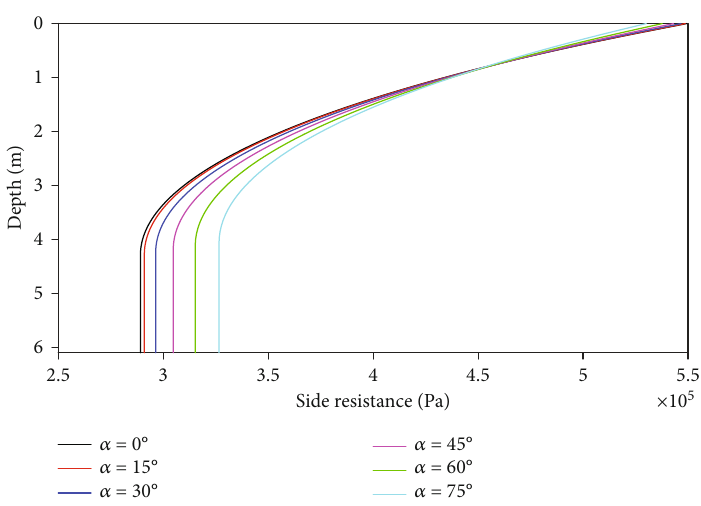
Figure 10: The in fl uence of slope angle on dilation unit side